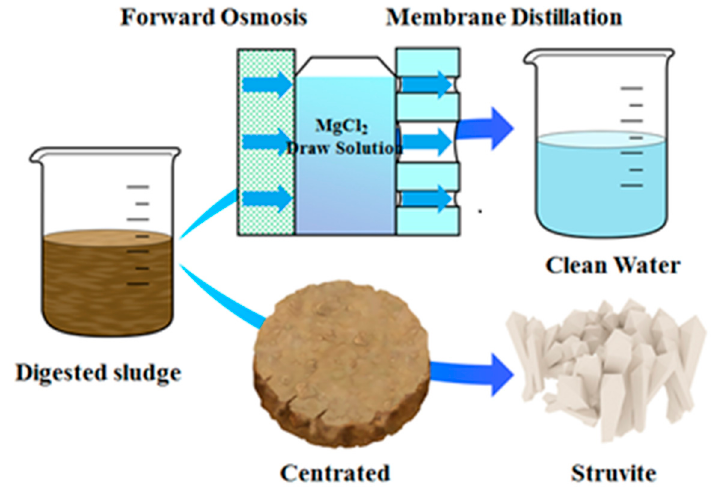
Figure 4. Schematic diagram of MgCl 2 as draw solution to drive FO process and recover nitrogen and phosphorus from sludge digestion liquid.